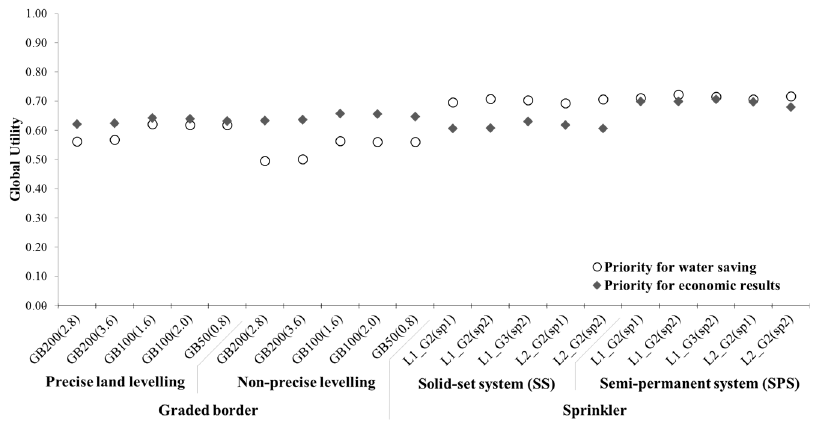
Figure 10. Comparing global utilities for sprinkler solid-set and semi-permanent systems with those for precise and non-precise levelled graded borders when priority is assigned to water saving or to economic returns. Sprinkler systems refer to layouts L1 and L2, spacings G2 and G3 and sprinklers sp1 and sp2. Graded borders have 50-, 100- and 200-m lengths and inflow rates from 0.8 to 3.6 L · s − 1 · m − 1